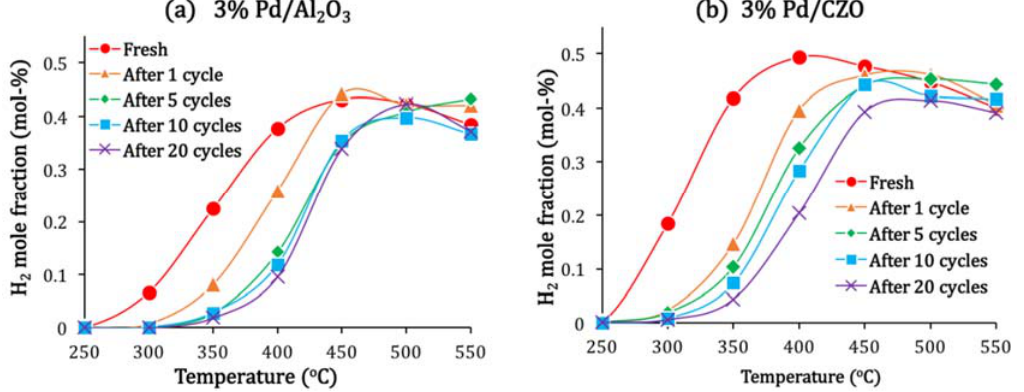
Figure 3. Activity of attempted regenerated ( a ) 3% Pd/Al 2 O 3 and ( b ) 3% Pd/CZO catalysts after 1, 5, 10, and 20 cycles in the aging-regeneration cycle tests. After every five cycles of aging/regeneration. The catalyst activity is plotted in terms of H 2 product mole fraction as a function of SR temperature from 250 °C to 550